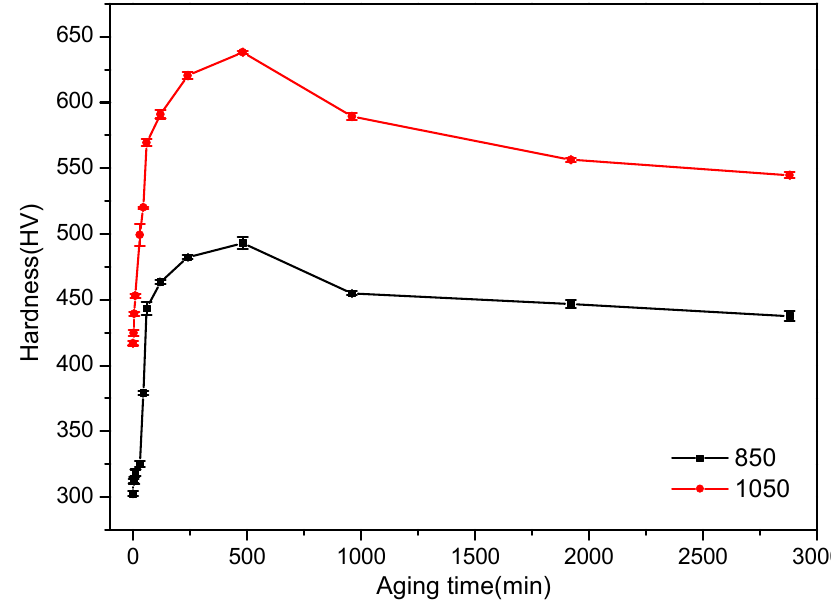
Figure 12. Microhardness of the samples aged at 500 °C as a function of aging time for Ti–3.5Al–5Mo–4V alloy after solution treatment at 850 and 1050 °C.